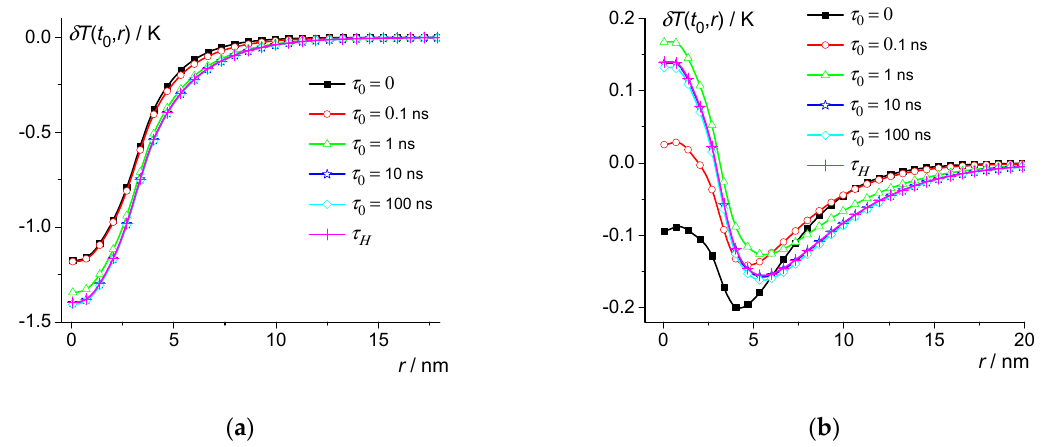
Figure 6. Dependence of the temperature change δ T ( t 0 , r ) on distance r at t 0 = 0.3 ns ( a ) and t 0 = 0.59 ns ( b ) for PBS at ∆ T = 60 K. τ 0 = 0, 0.1 ns, 1 ns, 10 ns and 100 ns—squares, circles, triangles, stars, and diamonds; crosses are the result of averaging δ T over the distribution H ( τ 0 ) The magnitude of the local temperature change 𝛿𝑇(𝑡, 𝑟) during the nucleation in PBS is about 1 K (see Figures 5 and 6) (a similar result was obtained for iPP). The effect of